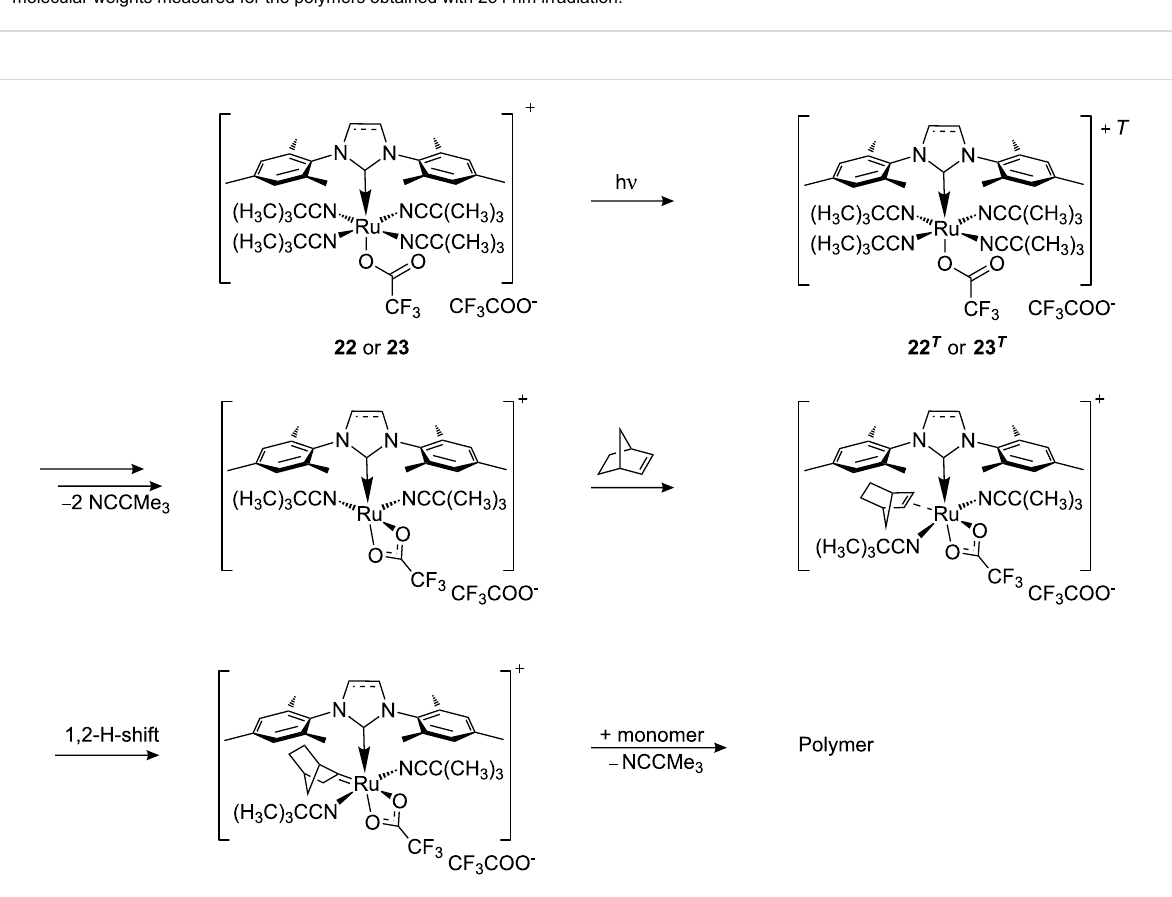
The thermal latency of the sulfur chelated complexes make them ideal candidates for photoswitchable applications; espe- cially in light of the well documented photodissociation of ruthenium sulfur